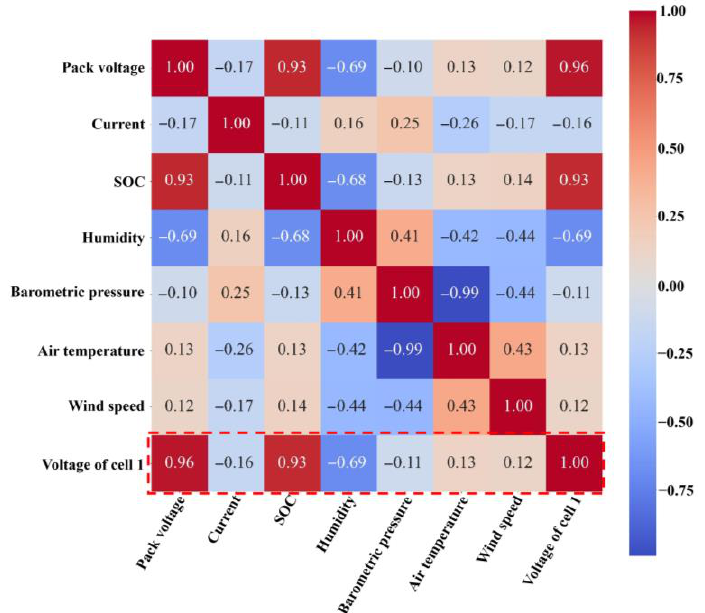
Figure 4. The correlation coefficient of data items.